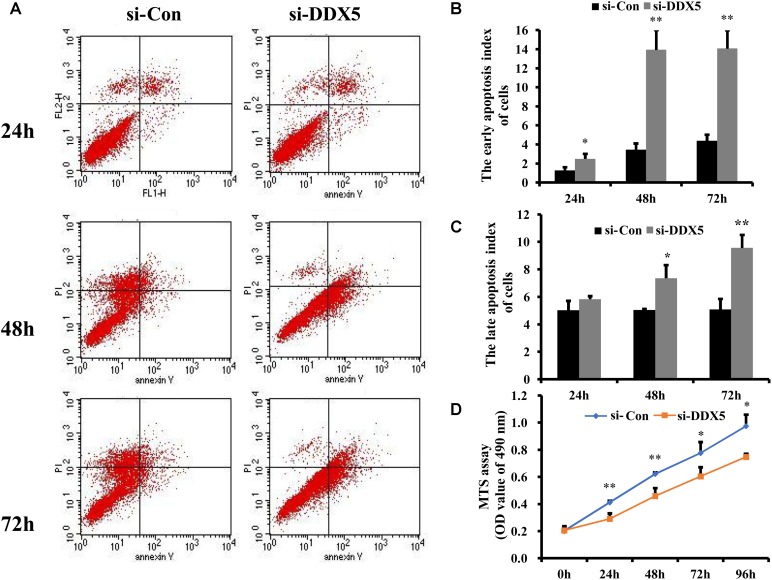
Knockdown of DDX5 inhibited proliferation and promoted apoptosis of MG63 cells in vitro. (A) Flow cytometry analysis showed the apoptosis index of MG63 cells treated with DDX5 siRNA (si-DDX5) and control siRNA (si-Con). (B) Bar chart showed the early apoptosis index of MG63 cells. (C) Bar chart showed the late apoptosis index of MG63 cells. (D) MTS assay showed that siRNA based knockdown of DDX5 inhibited the proliferation of MG63 cells, ∗P < 0.05, ∗∗P < 0.01 vs. si-Con.